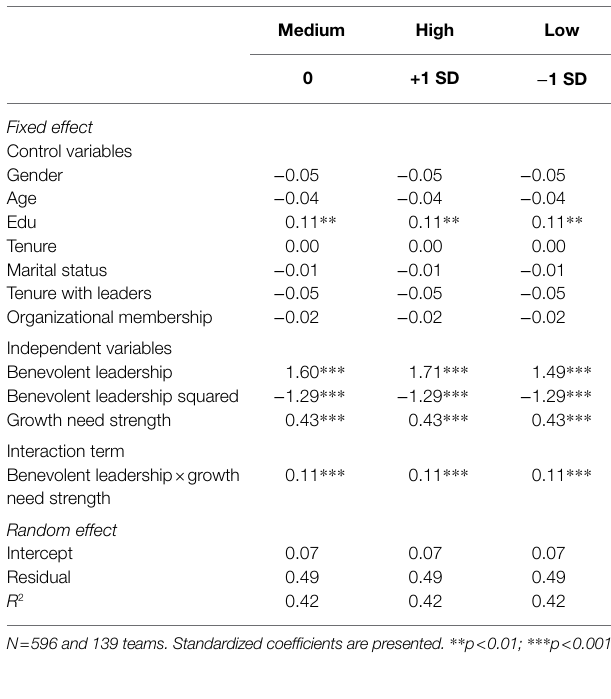
TABLE 7 | Moderating effect of growth need strength on the relationship between benevolent leadership and work engagement, individual level.